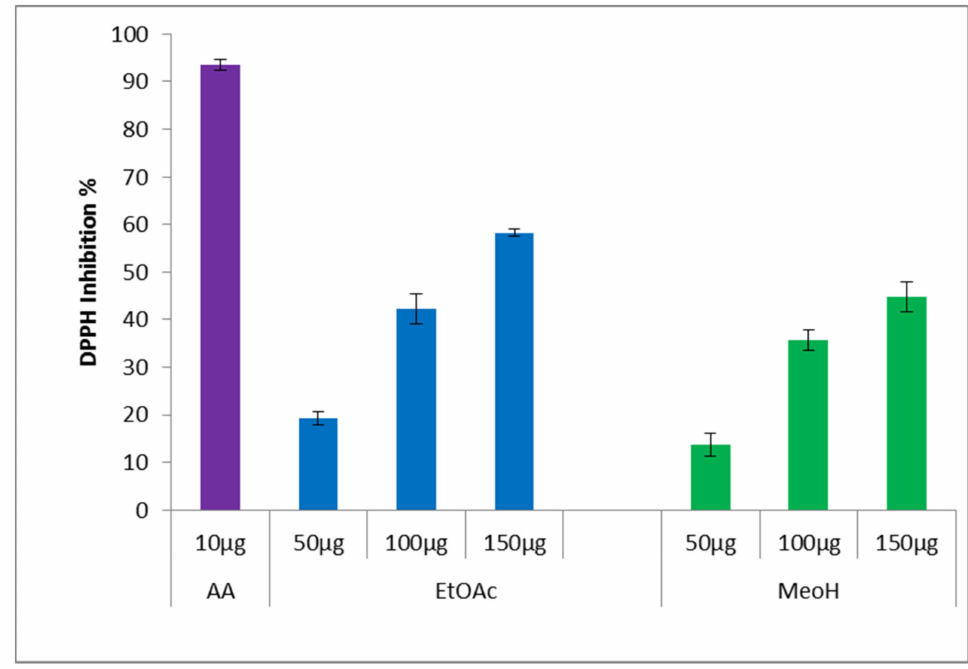
Figure 2. Antioxidant activity calculated by DPPH inhibition percentage of S. arghel ethyl acetate and methanol extracts at 50,100 and 150 µ g compared with control (Asorbic acid,